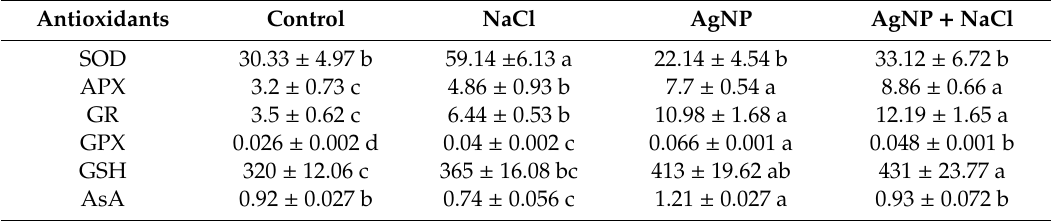
Table 2. Superoxide dismutase activity (SOD; U mg − 1 protein min − 1 ), ascorbate peroxidase activity